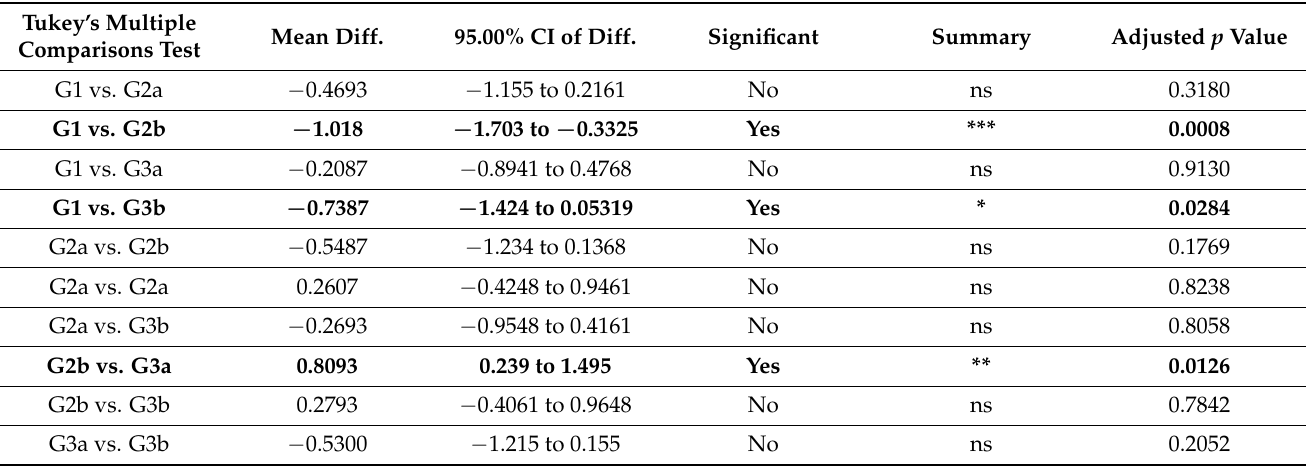
Table 4. Mean change of TKK baseline compared to 60 M. Tukey multiple comparison test between the groups. Differences were observed for groups G1 vs. G2b (no augmentation vs. CTG before), G1 vs. G3b (no augmentation vs. CTG after) and for groups G2b vs. G3a (CTG before vs. CMX after). Ns, non sugificant; *, ** and *** for a level of